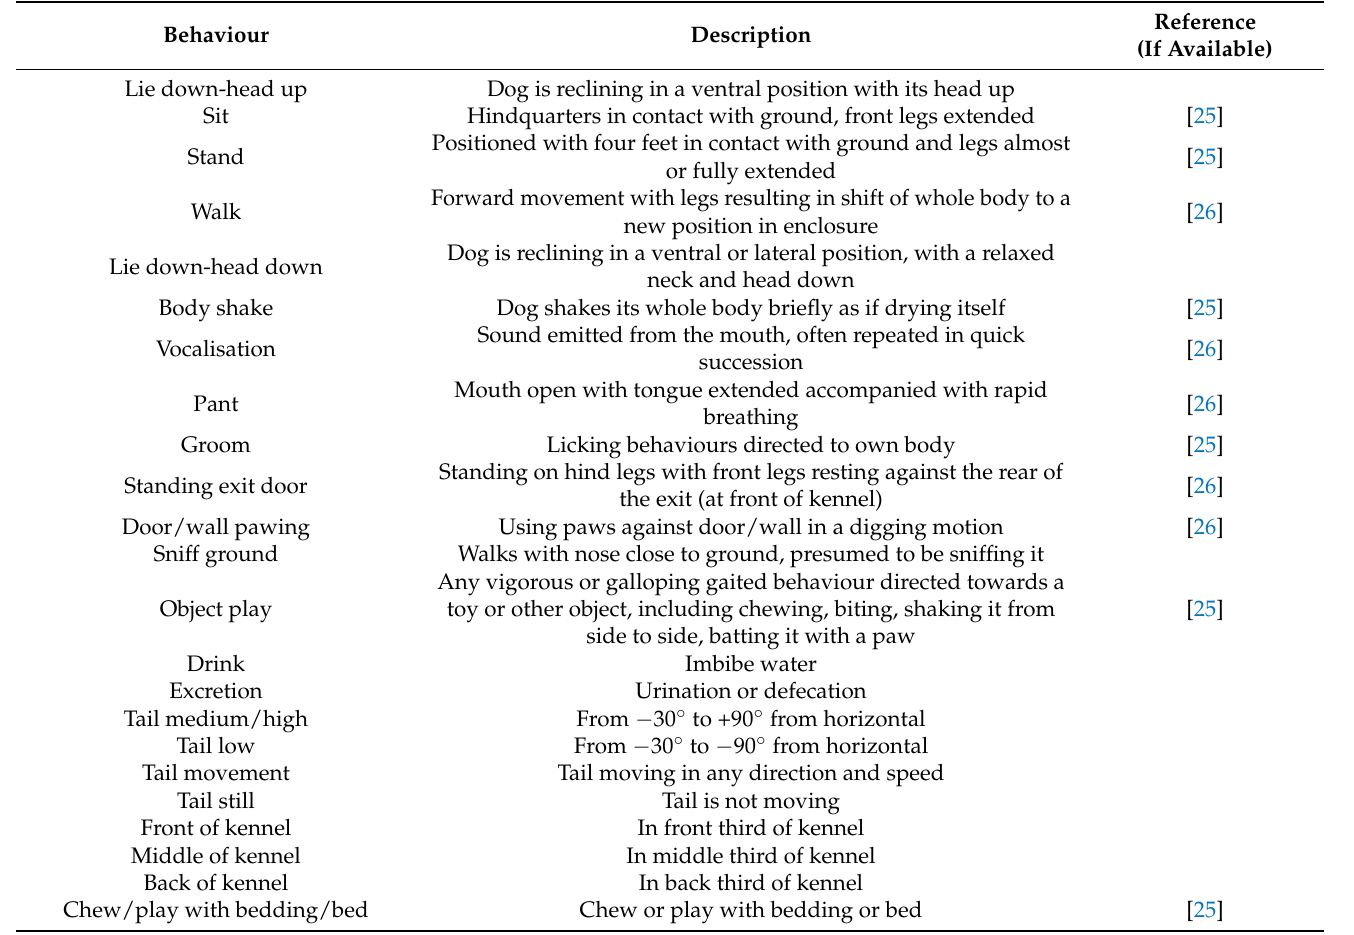
Table 2. Ethogram used for the measurement of the behaviours of dogs ( n = 10), with descriptors and references. Behaviour Description